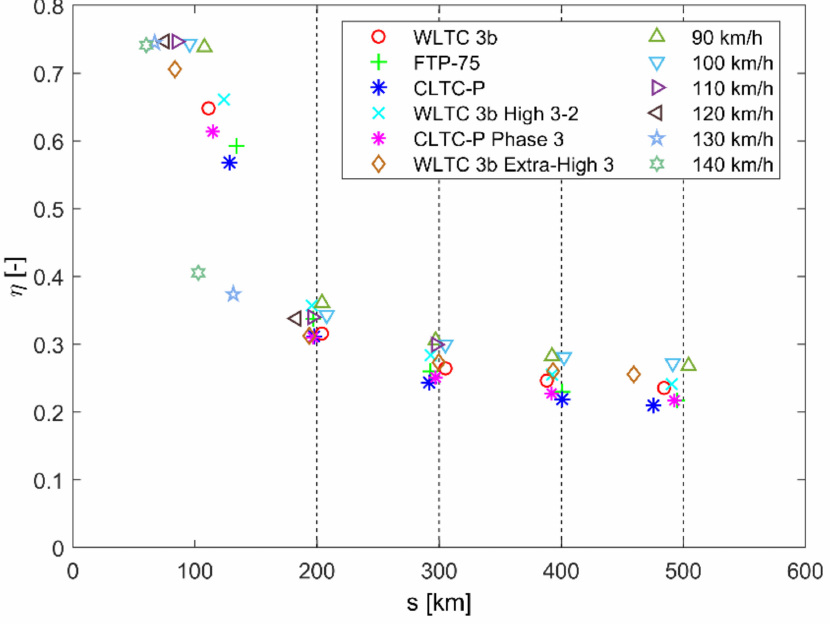
Figure A13. Efficiency results for BEV mode and EREV drive (four EREV range targets indicated with dashed vertical lines) in various drive cycle conditions. Vehicle mass is equal to 1800